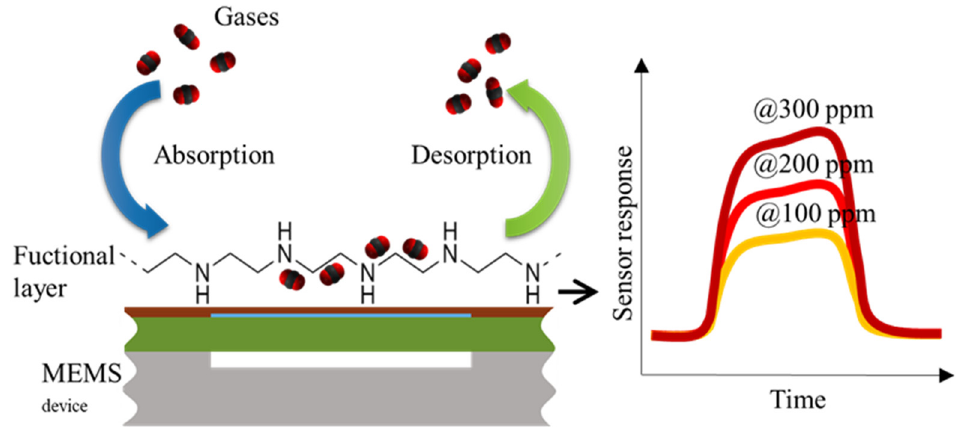
Figure 8. Main working principle of a gravimetric gas sensor using a functional layer